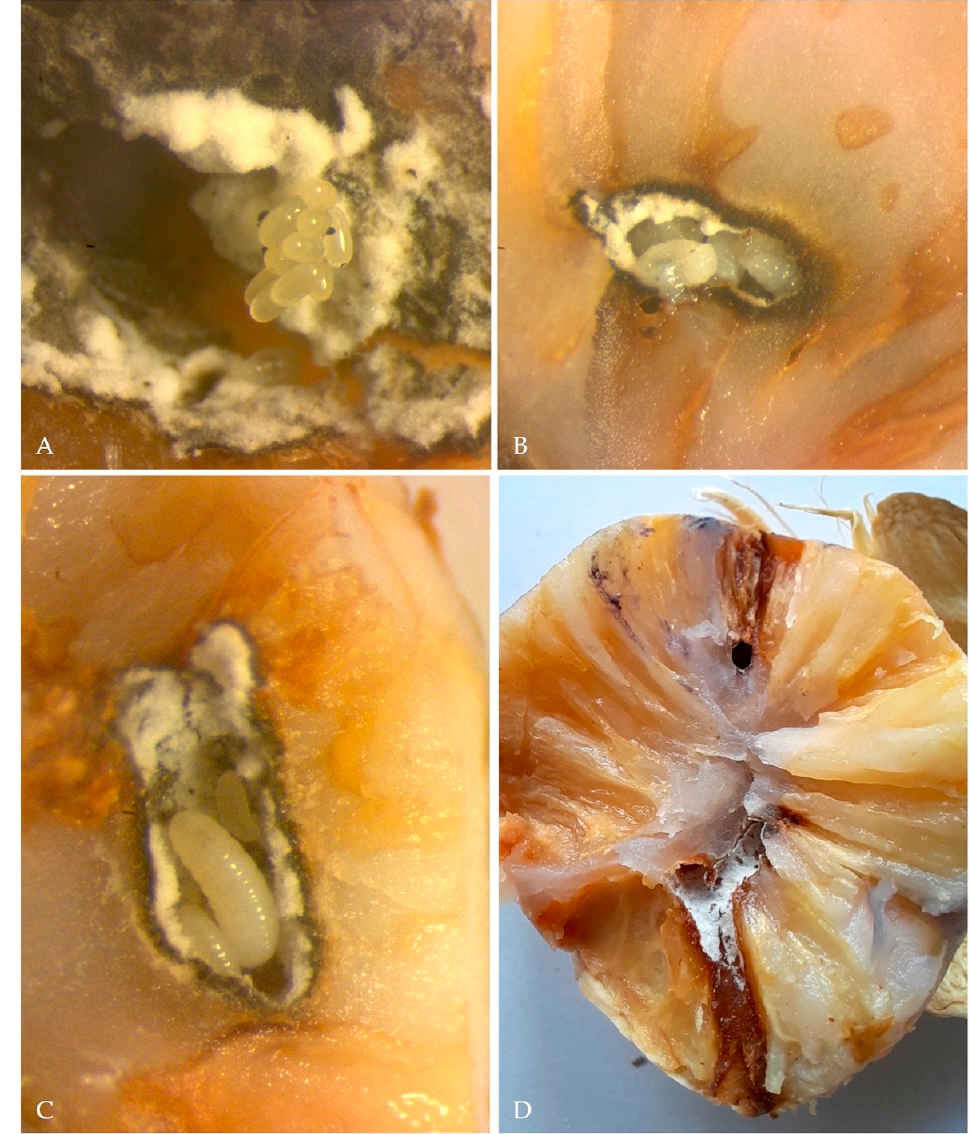
Figure 4. ( A ) eggs of X. crassiusculus ; ( B ) larvae of X. crassiusculus found in one of the galleries observed; ( C ) X. crassiusculus larvae at different development stages in association with A. roeperi hyphae; ( D ) longitudinal section illustrating X. crassiusculus galleries and kernel staining due to the onset of A. roeperi.